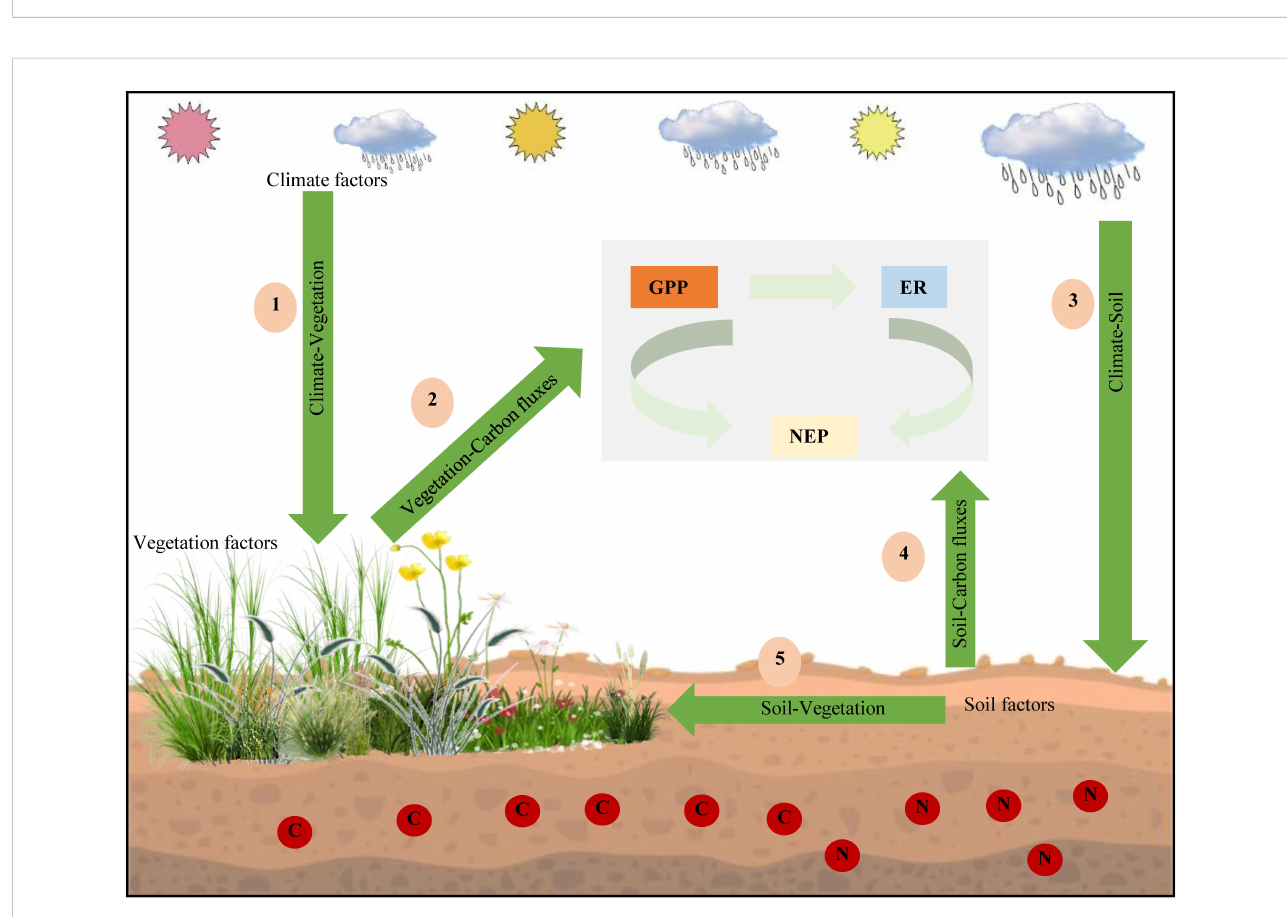
FIGURE 8 Biogeographic-ecological framework for the spatial variations in gross primary productivity (GPP), ecosystem respiration (ER), and net ecosystem productivity